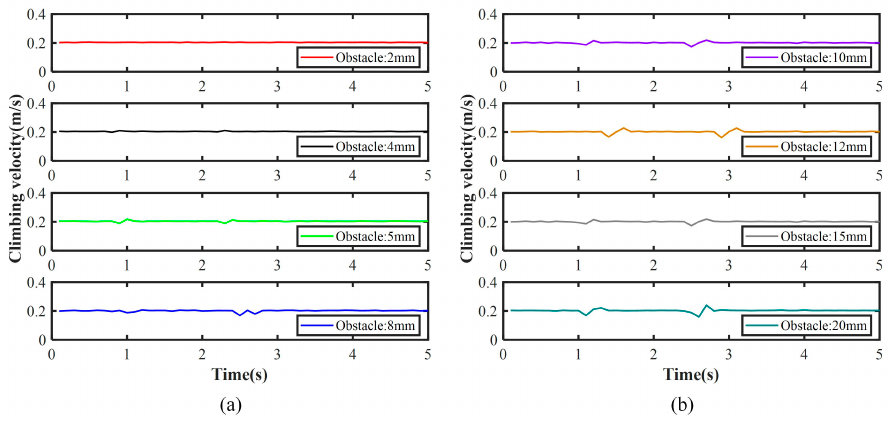
Figure 17. Robot velocity in obstacle-surmounting experiments. ( a ) Obstacle height: 2–8 mm; ( b ) Obstacle height: 10–20 mm.